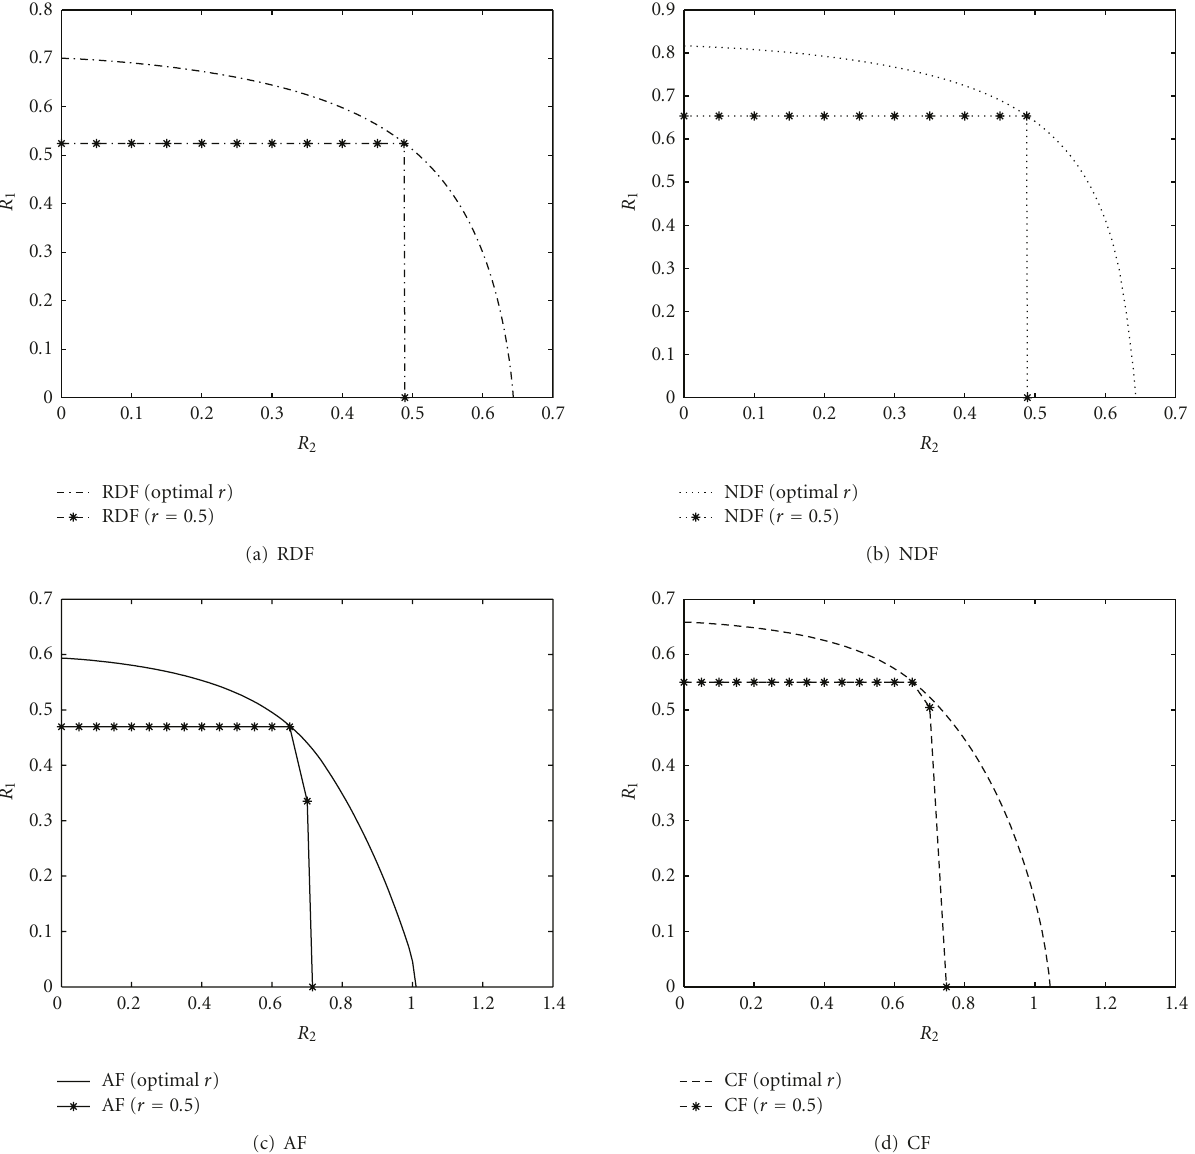
Figure 6: Comparisons between the achievable rate regions obtained by jointly optimal power and resource allocation and those obtained by power allocation only with equal resource allocation, for Scenario